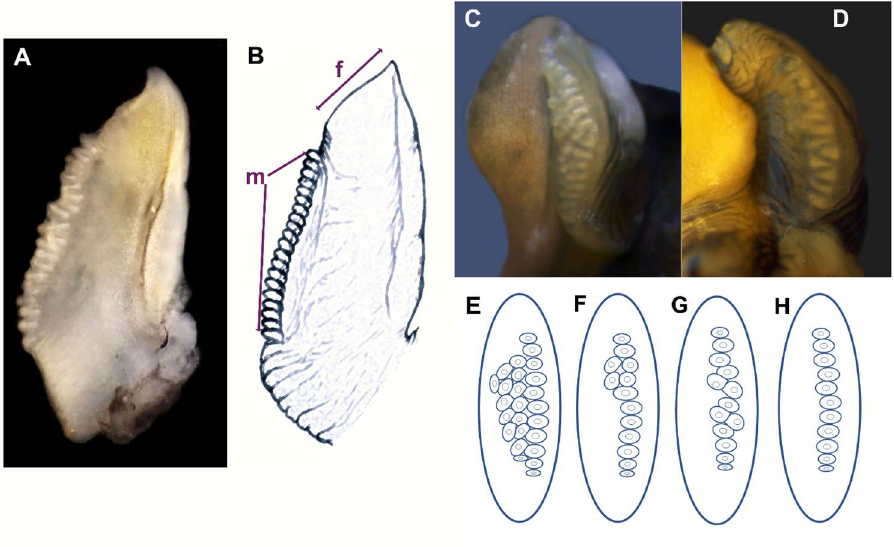
Figure 2. Morphology of a Littorina penis. ( A ) A photograph of L. saxatilis penis; ( B ) a scheme of a penis showing features important for identification—filament (f) and a row of mamilliform glands (m); ( C – H ) examples of penises with different numbers of gland rows; ( C ) multiple rows corresponds to scheme ( E ) (identified as L. arcana) ; ( D ) 1.5 rows (there are no glands in an opposite position, although several glands are out of the row) corresponds to scheme ( G ) (identified as L. saxatilis 1.5, presumably hybrids between L. arcana and L. saxatilis ); ( F ) two rows of penial glands, as two pairs of glands are in opposite position (identified as L. arcana ); ( H ) one even row of penial glands (identified as L. saxatilis 1